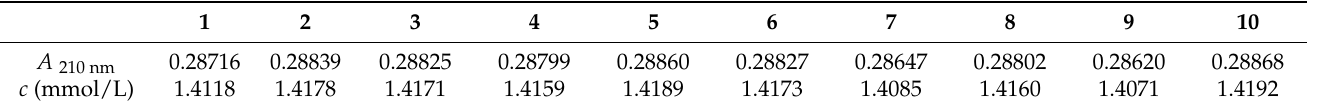
Table 1. Within-day repeatability of the spectrometric procedure tested on the 14.12 mmol/L